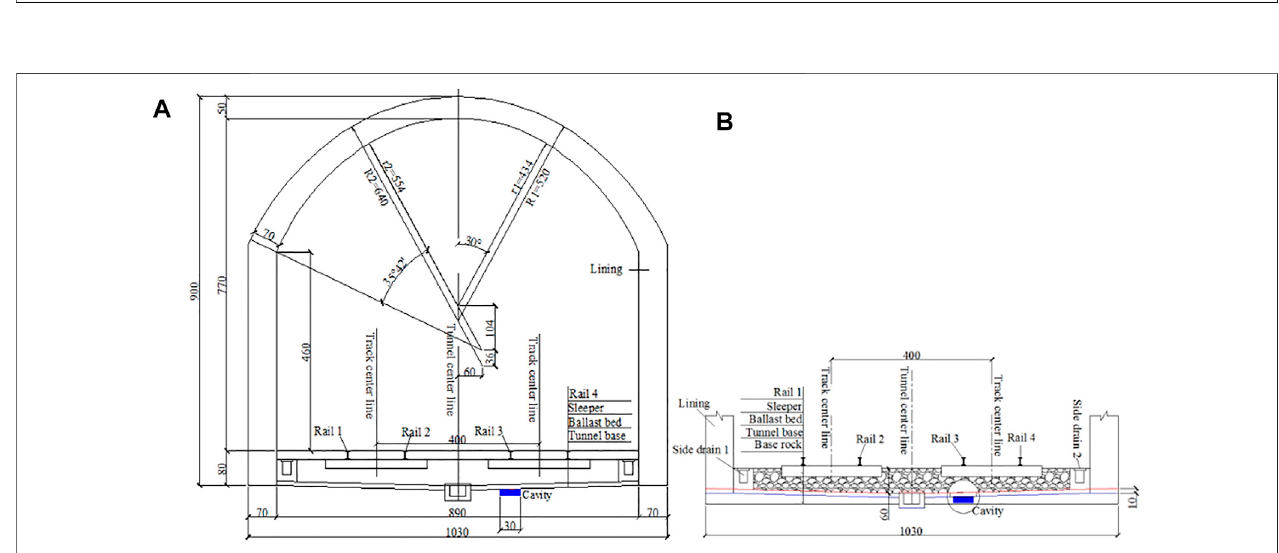
FIGURE 1 | Mud pumping in a tunnel of Daqin heavy haul railway. (A) mud-pumping below the rail; (B) mud-pumping from the side drain.